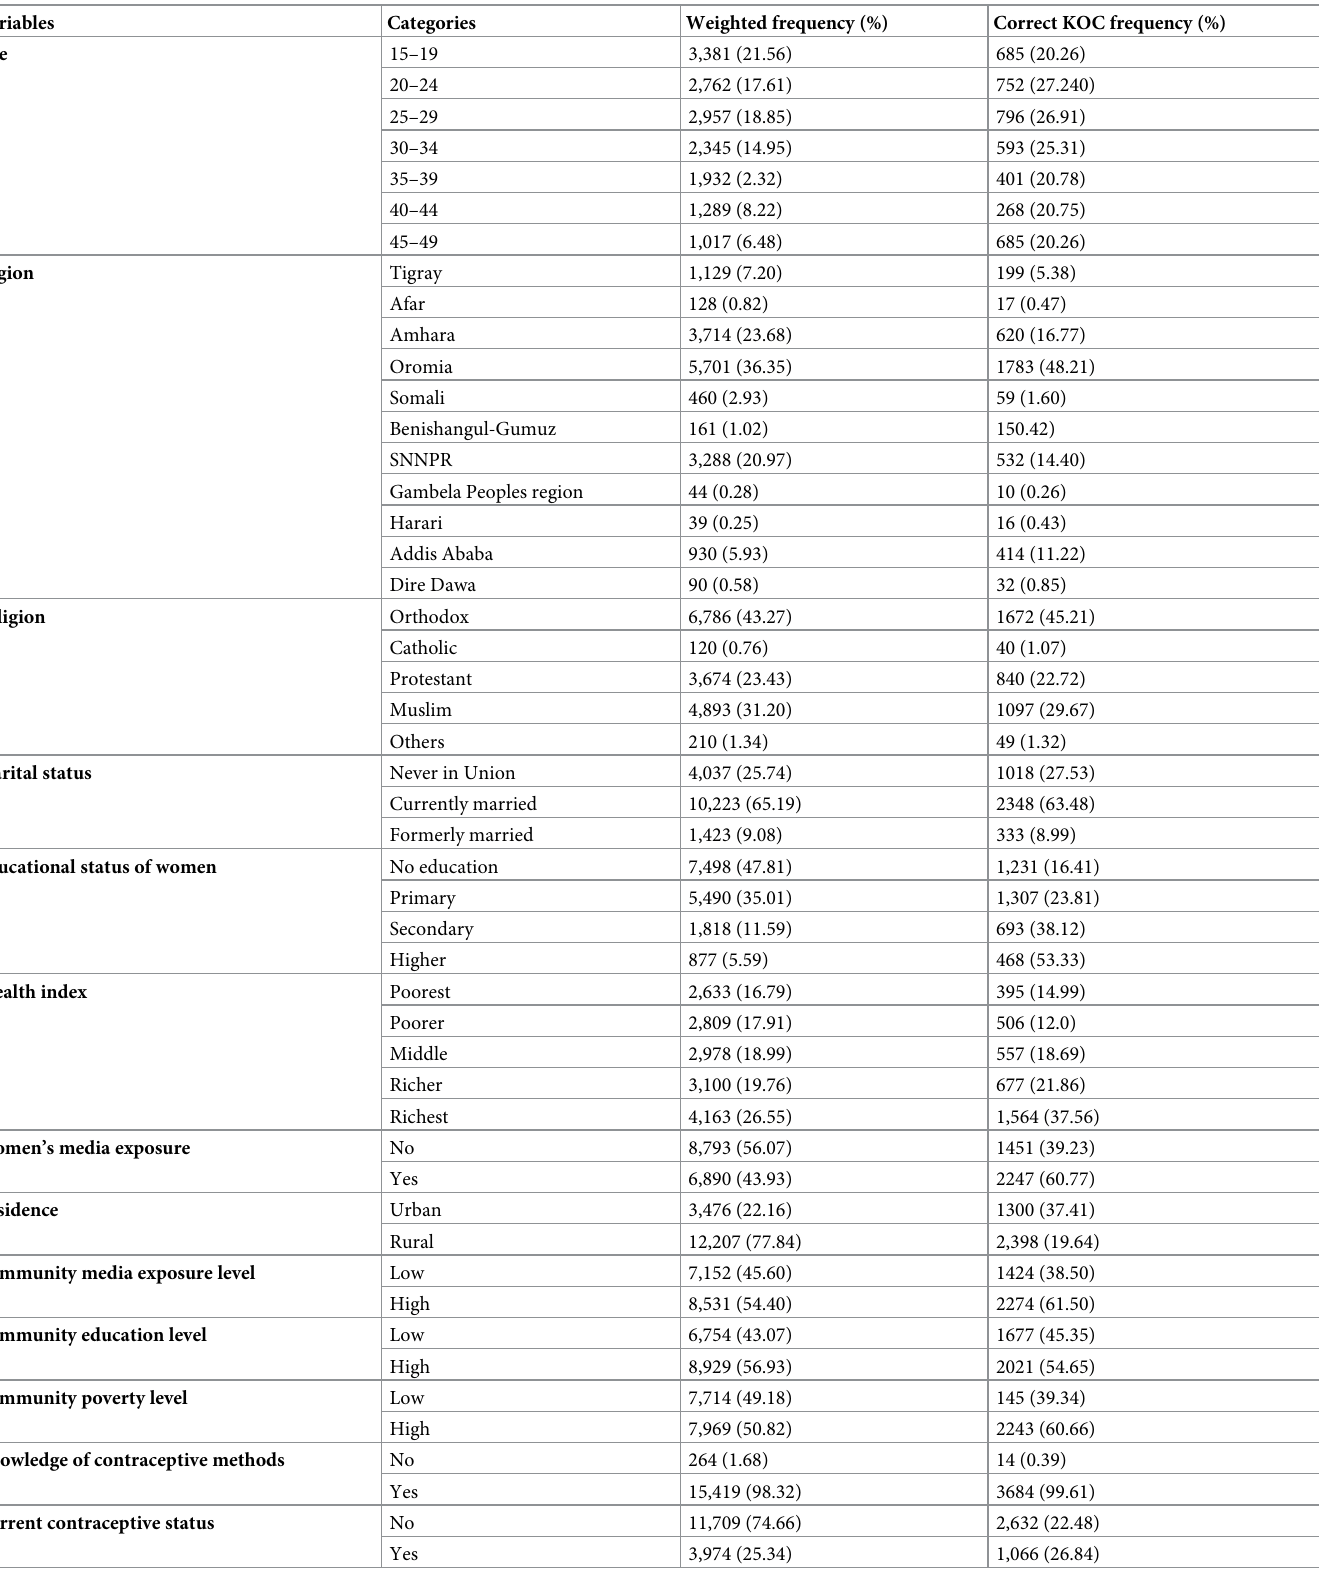
Table 1. Sociodemographic profiles of the participants on knowledge of the ovulatory cycle in Ethiopia (n =